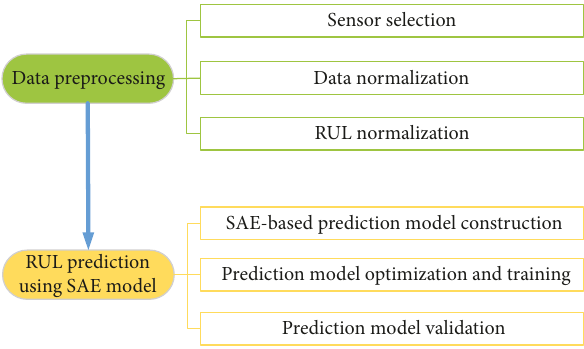
Figure 1: The procedure for predicting the RUL of an aircraft